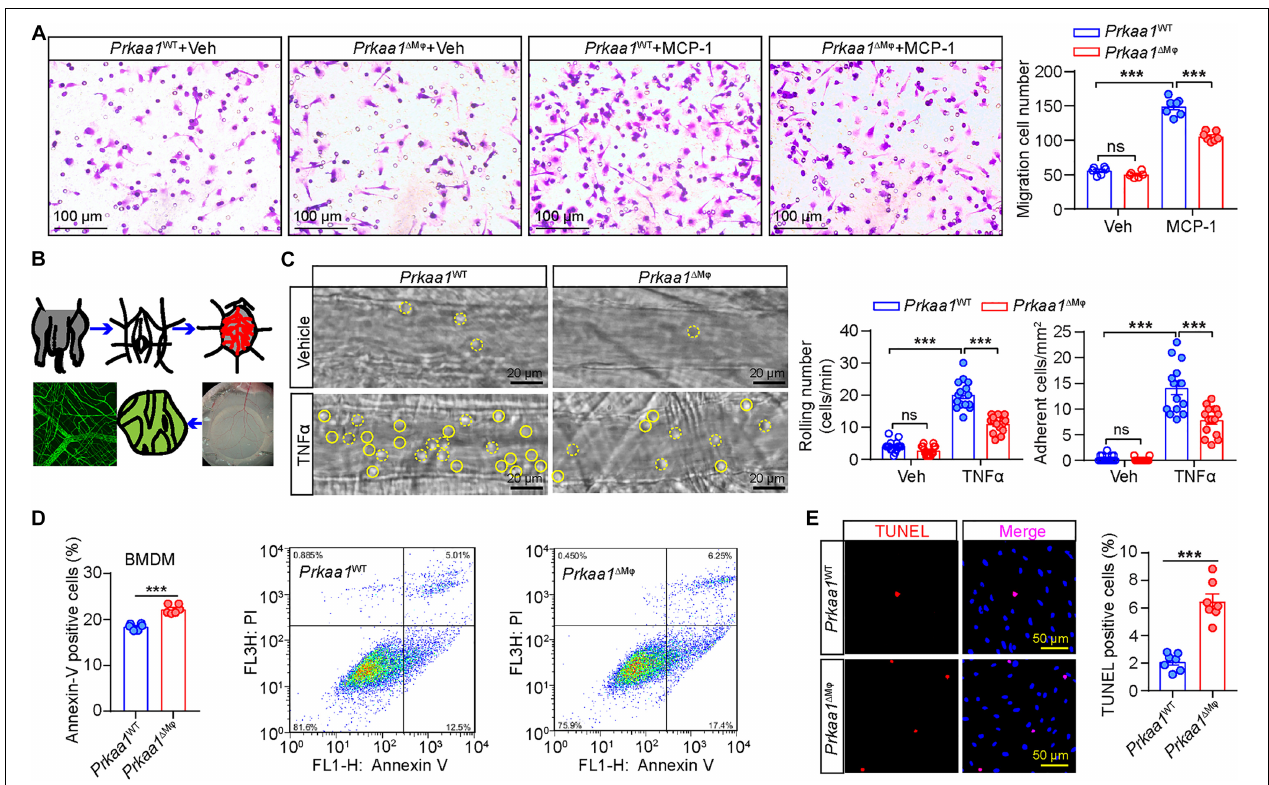
FIGURE 3 | Prkaa1-mediated metabolism is required for leukocyte recruitment and macrophage viability. (A) Representative images and quantification of MCP-1-induced migration between BMDMs cultured from Prkaa1 WT and Prkaa1 (cid:49) M ϕ mice. n = 7. Scale bars, 100 µ m. (B) Schematic illustration of en face staining of postcapillary venules of mouse cremaster muscle. (C) Representative images of leukocyte rolling and adhesion on the endothelium of postcapillary venules in the cremaster muscles of Prkaa1 (cid:49) M ϕ and Prkaa1 WT mice with TNF α or vehicle treatment for 4 h. Rolling and adherent cells are quantified and indicated with dotted and solid circle line, respectively (scale bar, 20 µ m). (D) Quantification data and representative images of flow cytometry analysis of Annexin V staining in BMDMs cultured from Prkaa1 WT and Prkaa1 (cid:49) M ϕ mice. n = 6. (E) Representative images and quantification data of TUNEL staining in BMDMs cultured from Prkaa1 WT and Prkaa1 (cid:49) M ϕ mice. n = 10, Scale bars, 50 µ m. All data are expressed as mean ± SEM. Statistical significance was determined by unpaired Student’s t -test. ∗∗∗ p <